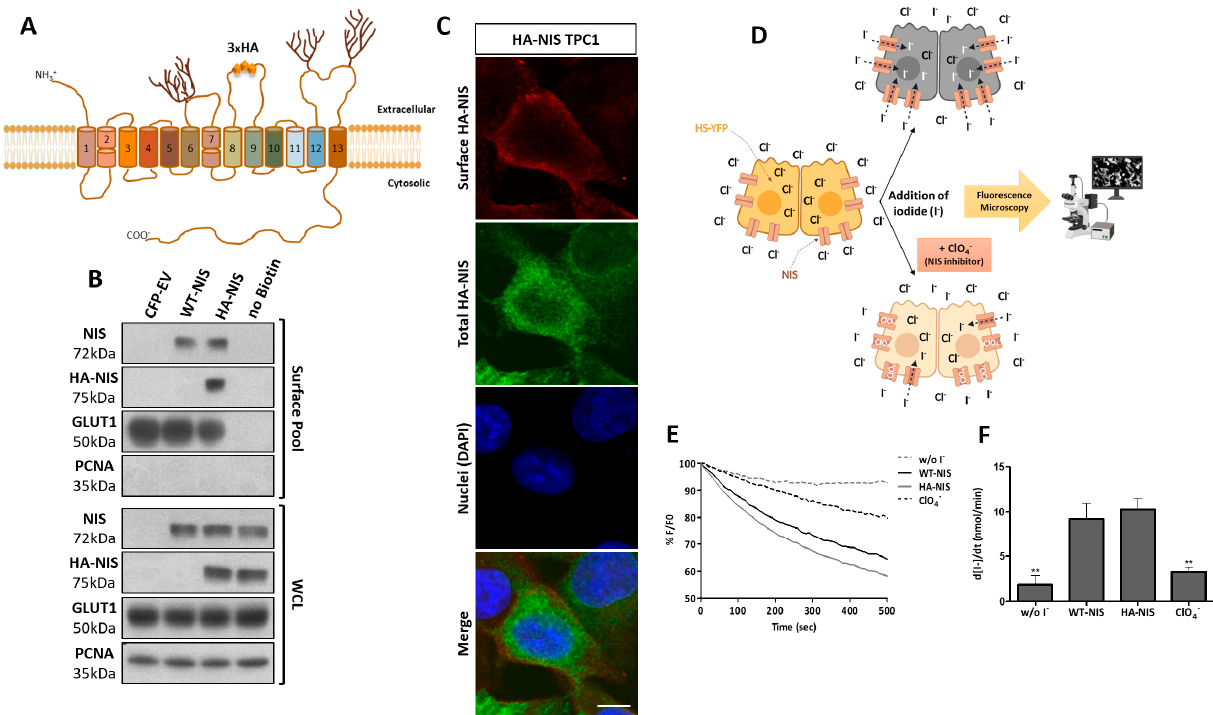
Figure 1. Production and characterization of the HA-NIS-expressing TPC1 cell line. ( A ) Diagram depicting the topology of NIS protein, showing the 13 transmembrane domains and the location of the inserted 3 × HA tag at the fourth extracellular loop. The TPC1 cells were modified to express the HA-NIS fusion protein, and then the cell line model was characterized regarding HA-NIS protein expression, trafficking to cell membrane and iodide transport function. ( B ) Cell surface proteins were biotinylated, and both the whole-cell lysates (WCL) and surface protein fraction were analyzed by Western blot to detect the HA-NIS protein, using anti-HA and anti-NIS primary antibodies. TPC1 expressing either CFP or WT-NIS cells was used as the negative and positive control, respectively, for the HA-NIS protein expression. The ‘no Biotin’ condition, corresponding to cells that were not incubated with biotin, was used as the control for non-biotinylated protein capture. PCNA served as the loading (WCL) and intracellular protein contamination control (Surface pool). GLUT-1 served as the positive loading control for the cell-surface protein extracts. ( C ) Confocal images of tripled labelled HA-NIS-TPC1 cells, where Alexa Fluor 633 fluorescence (red) indicates HA-NIS protein present at the surface of intact cells, labeled with a rabbit anti-HA primary antibody, prior to the cell fixation and permeabilization. Alexa Fluor 488 fluorescence (green) indicates the total HA-NIS protein, labeled with a mouse anti-HA primary antibody after cell permeabilization. The nuclei were stained with DAPI (blue). ( D ) Diagram depicting the fluorescent iodide influx assay. HA-NIS-TPC1 cells stably expressing the YFP halide sensor (HS-YFP) were used to analyze the HA-NIS protein function. The decay of the YFP fluorescence was monitored continuously for 500 s, acquiring an image every 10 s, after exposing the cells to 50 mM NaI. The presence of a competitive inhibitor of iodide uptake by NIS (ClO 4 − ) slows or prevents the decay of YFP fluorescence over time (image created with BioRender.com, accessed on 26 July 2021). ( E ) Representative traces of HS-YFP decay upon the exposure of WT-NIS- or HA-NIS- expressing TPC1 cells to iodide (I − ), in the presence or absence of pretreatment with 50 mM ClO 4 − . Fluorescence [F] was plotted over time as percentage of the fluorescence at time 0 [F 0 ]. “w/o I − ” relays the fluorescence values in cells assayed in I − -free medium. ( F ) Iodide influx rates calculated by fitting the curves to the exponential decay function to derive the maximal slope that are proportional to the initial rate of I- influx into the cells. The data are means ± SEM of five independent assays. A one-way ANOVA analysis detected significant differences between the treatments (F = 15.02; p < 0.001). Post-hoc Dunnett’s tests were used to identify significant variations relative to WT-NIS (** p ≤ 0.